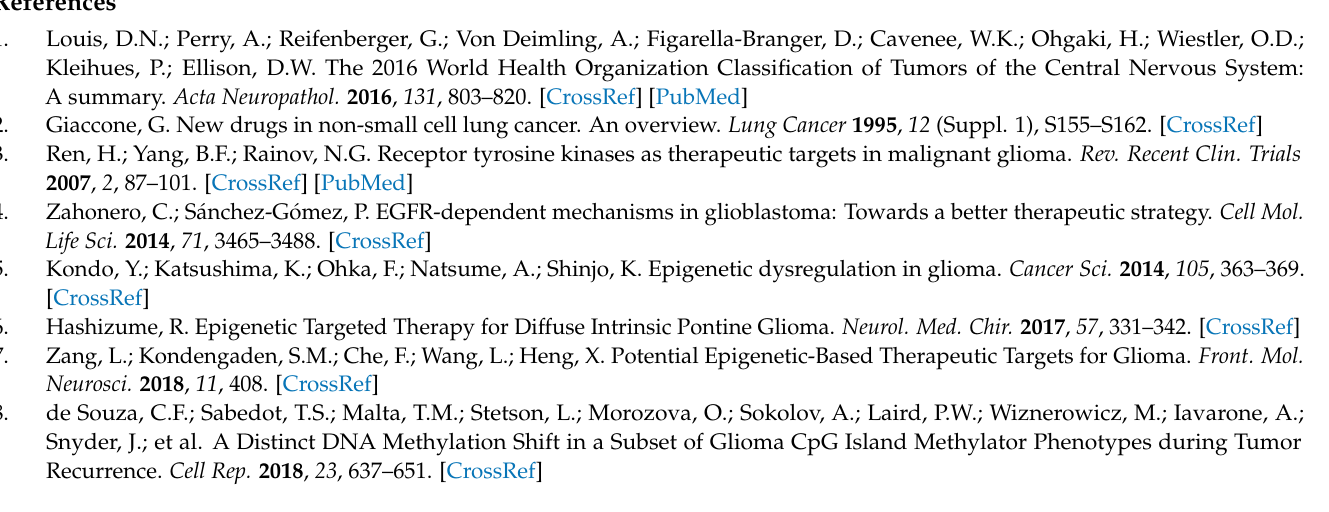
experiments; Figure S1: Flow cytometry controls. White cells and isotypic controls in gliomas and control brains; Figure S2: Expression of h5-HT 7 R in “small” and “large” brains expressing h5-HT 7 R ( repo>dp110 CAAX ; h5-HT 7 R; dEGFR λ ). Controls are w 1118 brains. Antibodies directed against the FLAG tag were used; Figure S3: PLS–DA score plots. (a) Comparison of controls brains ( repo-Gal4 ), and “small” brains expressing h5-HT 7 R in a glioma context, (b) Comparison of controls brains ( repo-Gal4 ), and “large” brains expressing h5-HT 7 R in a glioma context. (c) Comparison of gliomas and “small” brains expressing h5-HT 7 R in a glioma context, (d) Comparison of gliomas and “large” brains expressing h5-HT 7 R in a glioma context; Figure S4: Analysis of H3 content and H3K4me2/3 by flow cytometry in glial cells (GFP labelled cells). Pattern of H3 labelling and H3K4me2/3 labelling in glial cells are shown for controls ( repo>GFP ) and glioma ( repo>dp110 CAAX ; dEGFR λ ). Two populations of glial cells P1 and P2 differing by their methylation rate have been